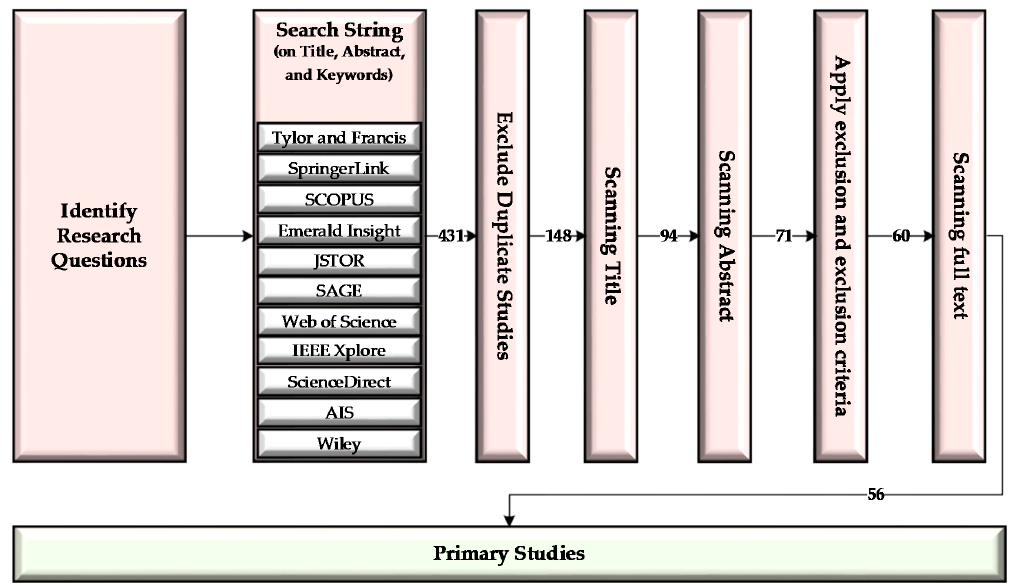
Figure 1. Procedure for identifying primary studies.